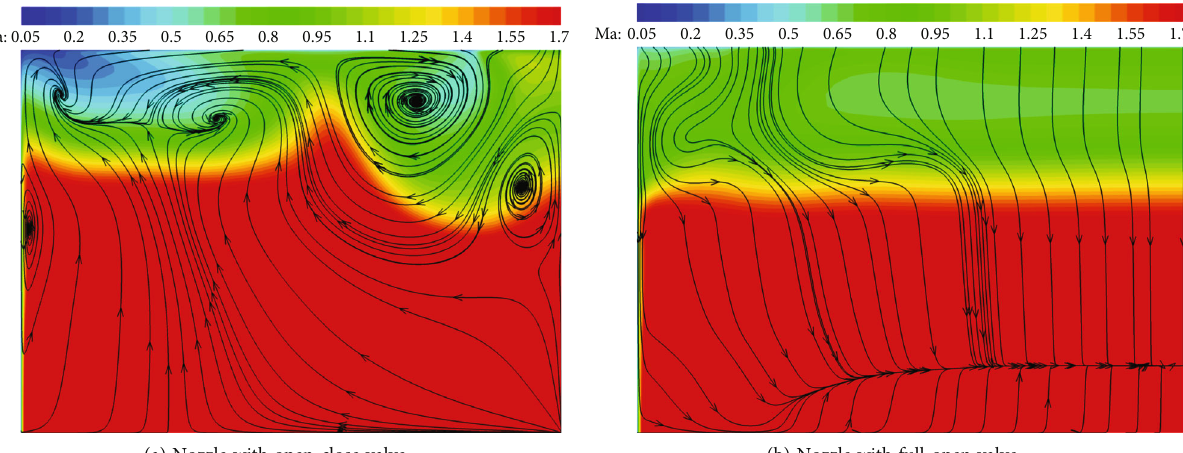
Figure 13: Vortex structure of monitoring surface c